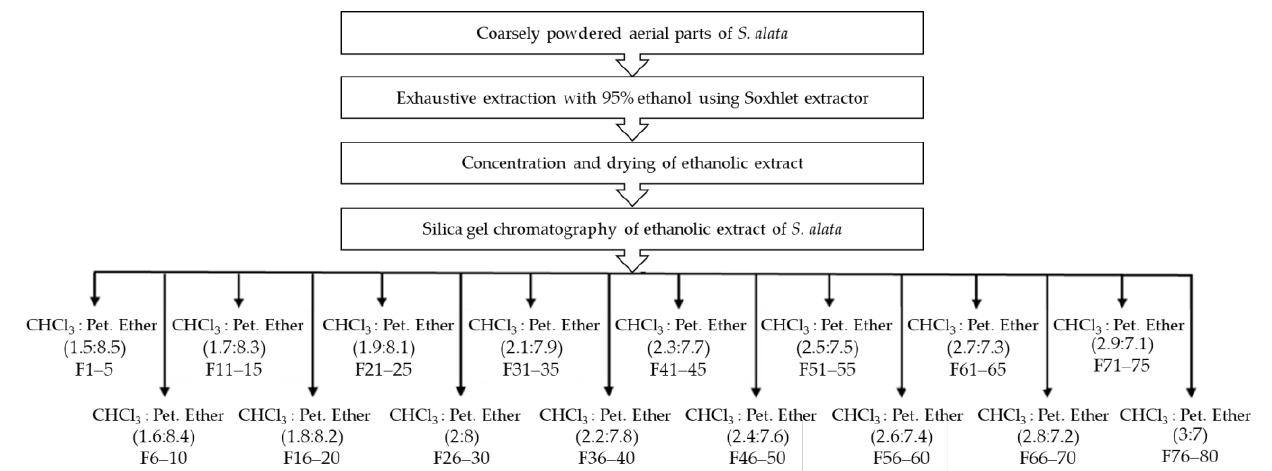
Figure 4. Flowchart representing the extraction and isolation of phytoisolates from S. alata extract using various fractions of chloroform and petoleum ether as eluent.